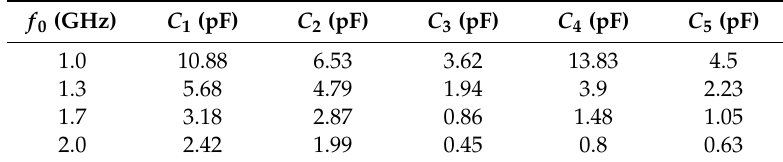
Table 1. Capacitance of the varactors for di ff erent frequencies.